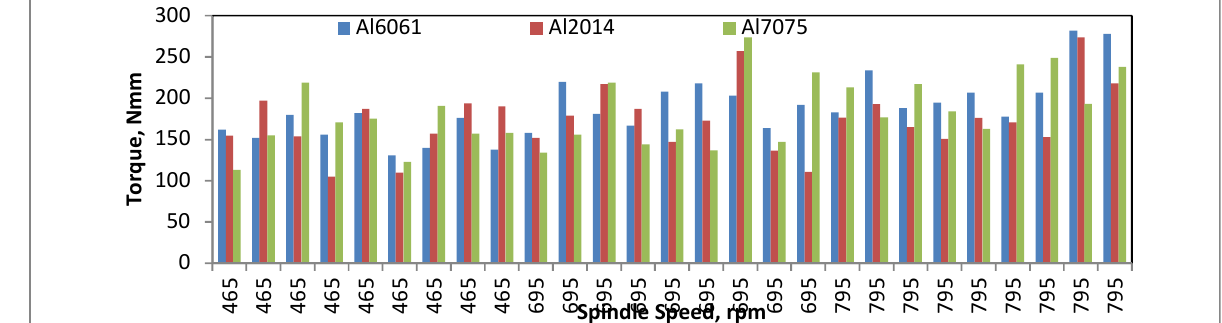
Fig. 10 . Effect of variation of the spindle speed on torque